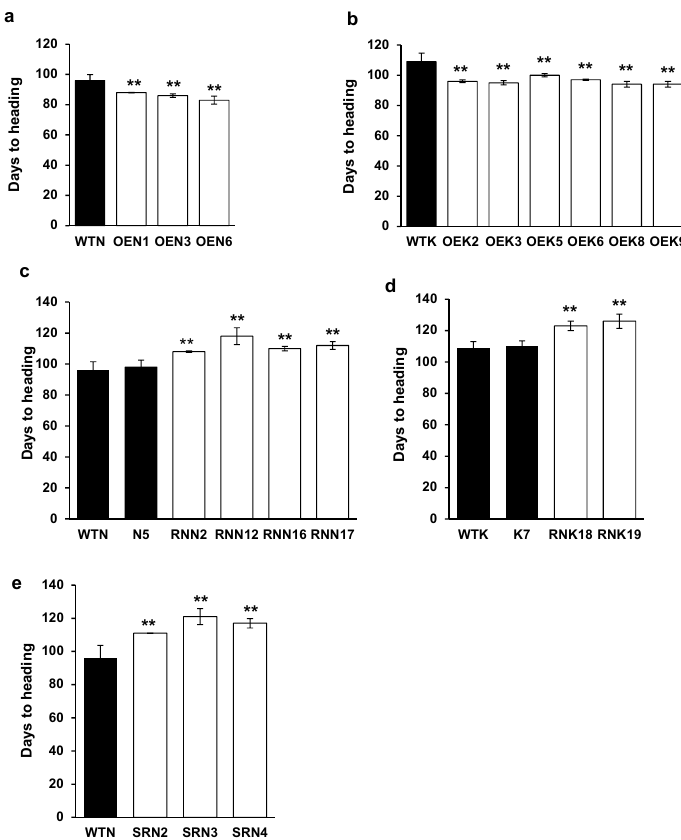
Figure 4. Number of days to heading. Seeds were sown in soil and allowed to grow in a greenhouse under natural photoperiod conditions. Time required from sowing to heading was